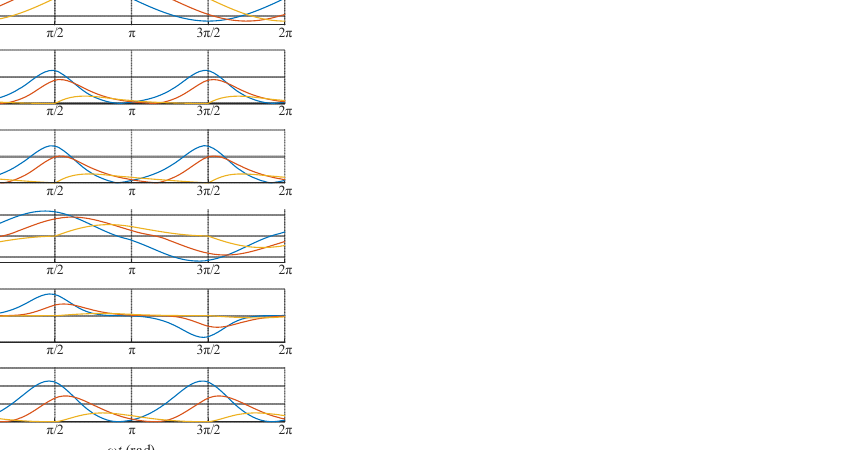
Figure 8. The calculation results at f s = 10 kHz, L = 120 μ H, and C = 80 μ F.